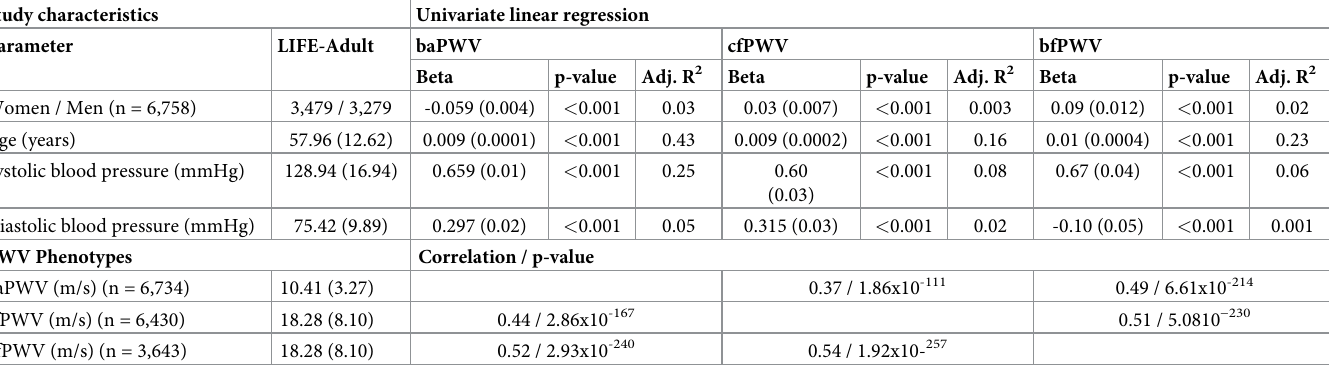
Table 2. Upper table: Study characteristics of LIFE-Adult: Analysis is restricted to participants/patients for which genotypes and systolic blood pressures are available. Study